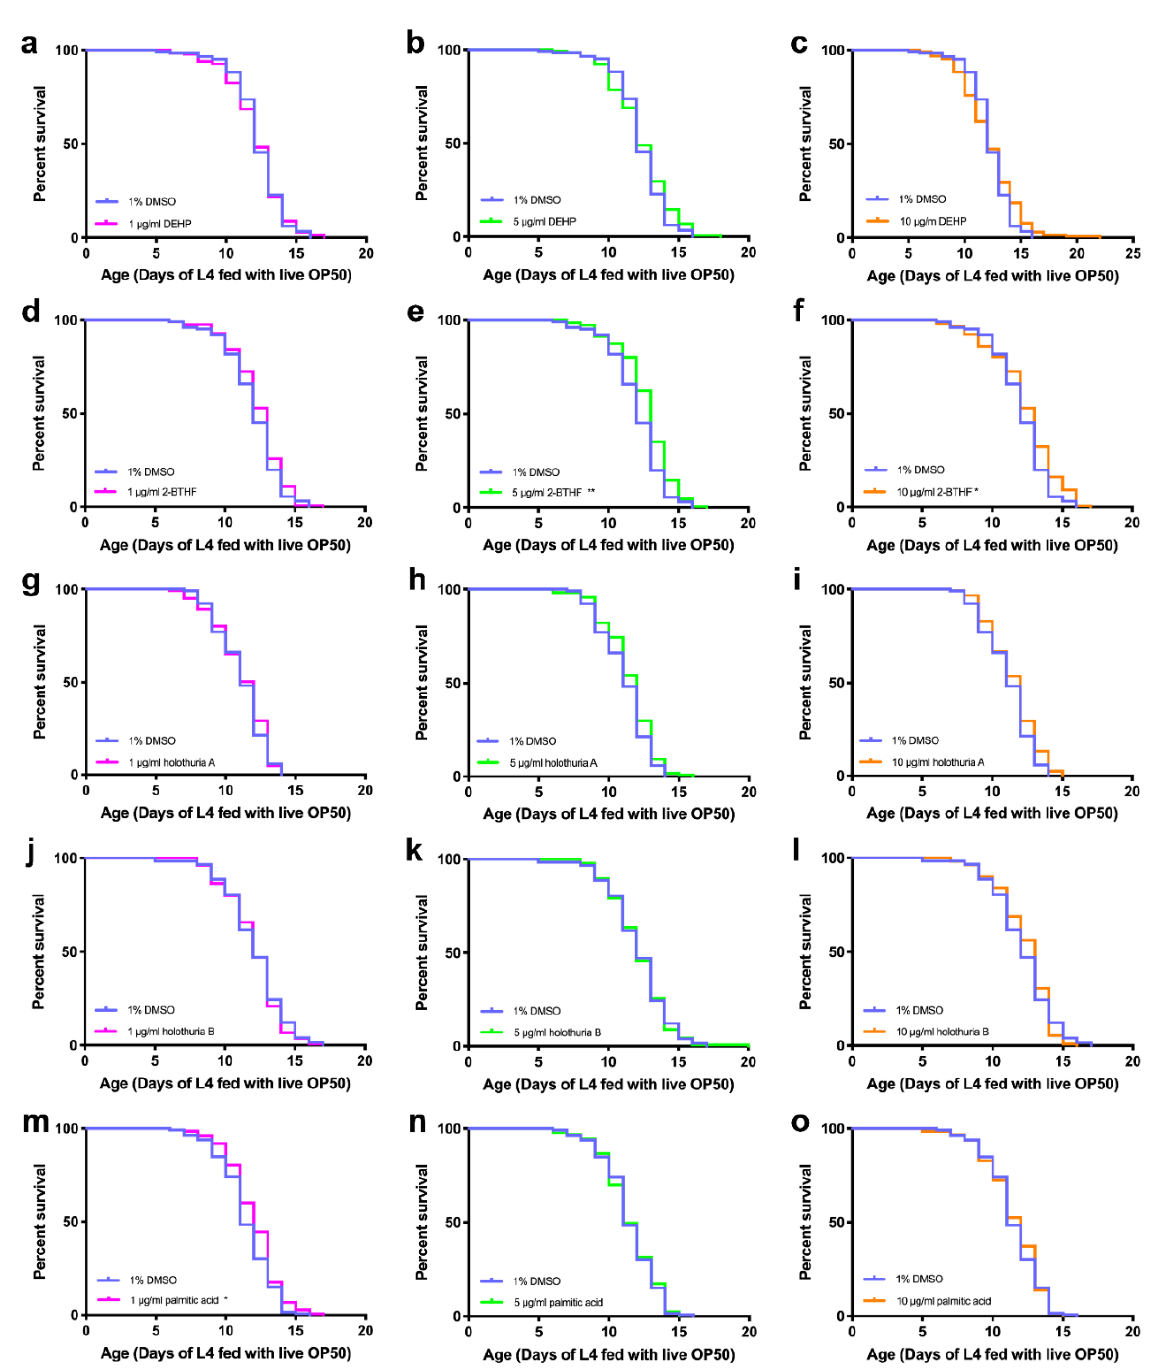
Figure 1. Effects of the compounds derived from H. scabra extracts on the lifespan of wildtype N2 worms. The survival curves showed the lifespans of worms treated with 1 μ g/mL DEHP ( a ), 5 μ g/mL DEHP ( b ), 10 μ g/mL DEHP ( c ), 1 μ g/mL 2-BTHF ( d ), 5 μ g/mL 2-BTHF ( e ), 10 μ g/mL 2-BTHF ( f ), 1 μ g/mL holothuria A ( g ), 5 μ g/mL holothuria A ( h ), 10 μ g/mL holothuria A ( i ), 1 μ g/mL holothuria B ( j ), 5 μ g/mL holothuria B ( k ), 10 μ g/mL holothuria B ( l ), 1 μ g/mL palmitic acid ( m ), 5 μ g/mL palmitic acid ( n ), and 10 μ g/mL palmitic acid ( o ) compared to the control. The survival curves were analyzed by using the log-rank (Mantel-Cox) test for p values, * p < 0.05 and ** p < 0.01.